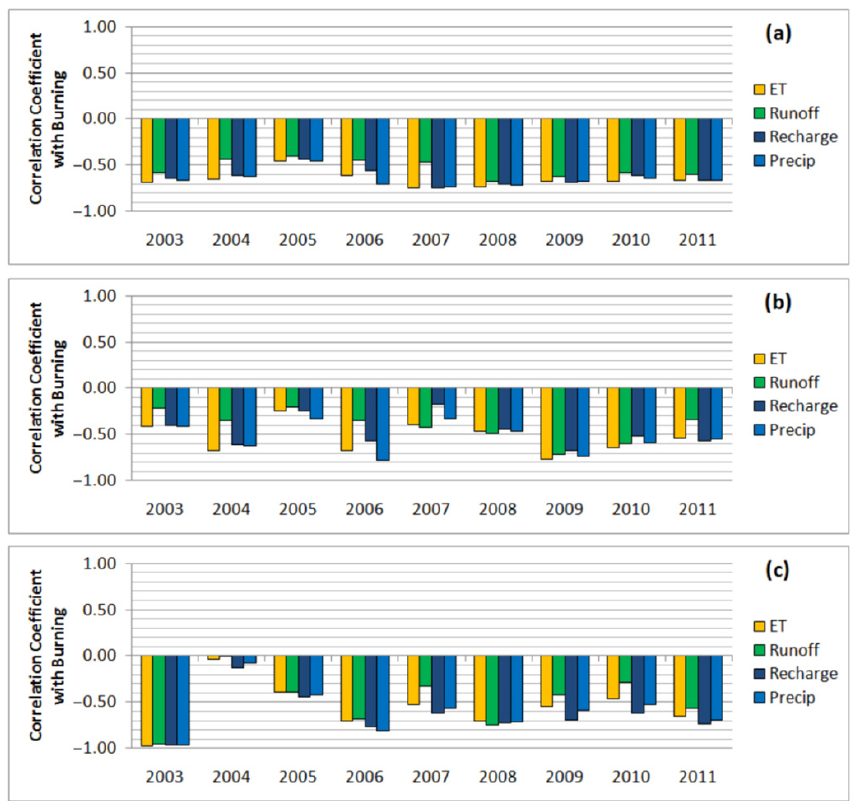
Figure 7. Correlation coefficients between biomass burning count (each count being 2 km × 2 km pixel) from MOD14/MYD14 Collection 5 compared to water balance model outputs, considering burning based on different time periods: ( a ) integration or averaging through the full-year cycle, ( b ) integration or averaging through only the dry season, and ( c ) integration or averaging through only the wet season.